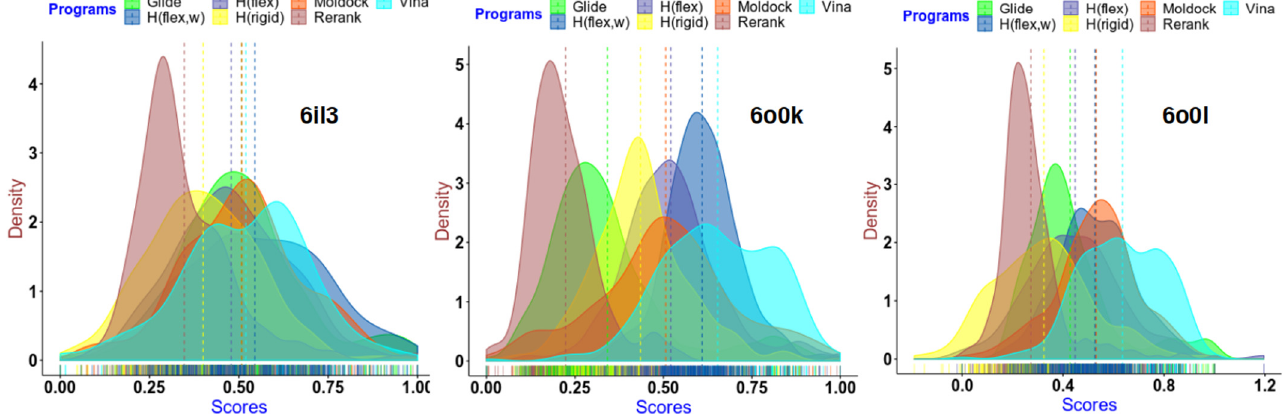
Figure 2. The distribution of the normalized docking scores of all of the molecules across the seven docking scores, showing the level of overlap and mean value (dash line).